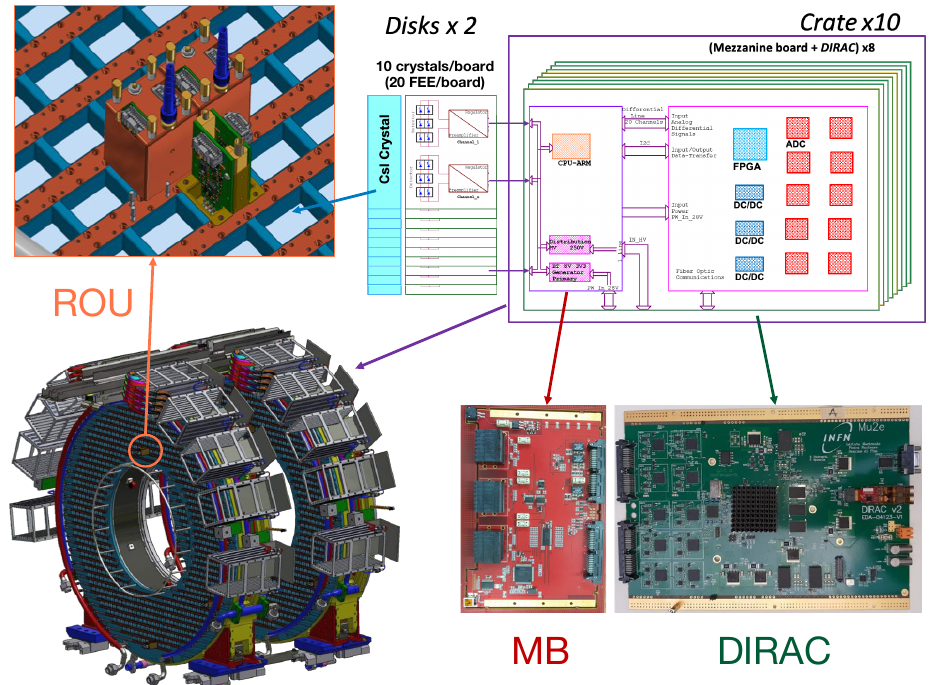
Figure 1. Overview of the Mu2e calorimeter readout system. Top-left: detail of the readout units (ROU) assembly in the calorimeter disk (heat exchangers are also visible). The electronics crates’ architecture, including mezzanine (MB) and DiRAC boards, is also shown on the